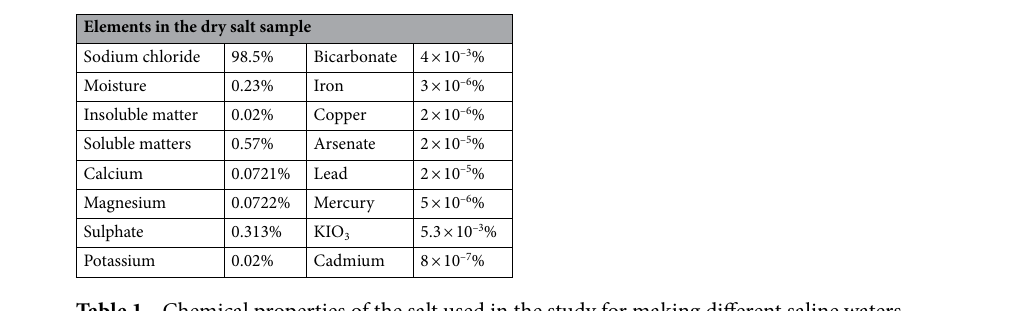
Table 1. Chemical properties of the salt used in the study for making different saline